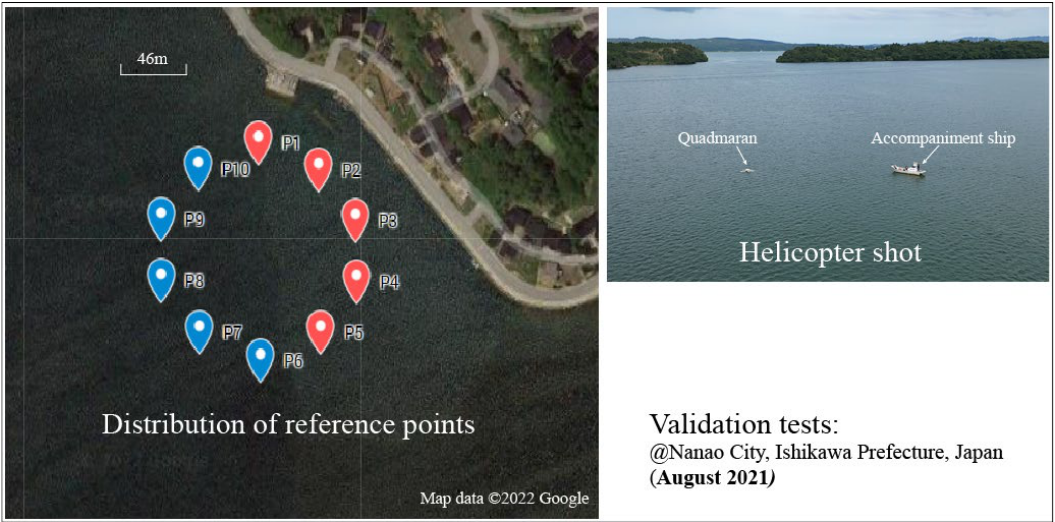
Figure 20. Validation tests in the actual sea area.